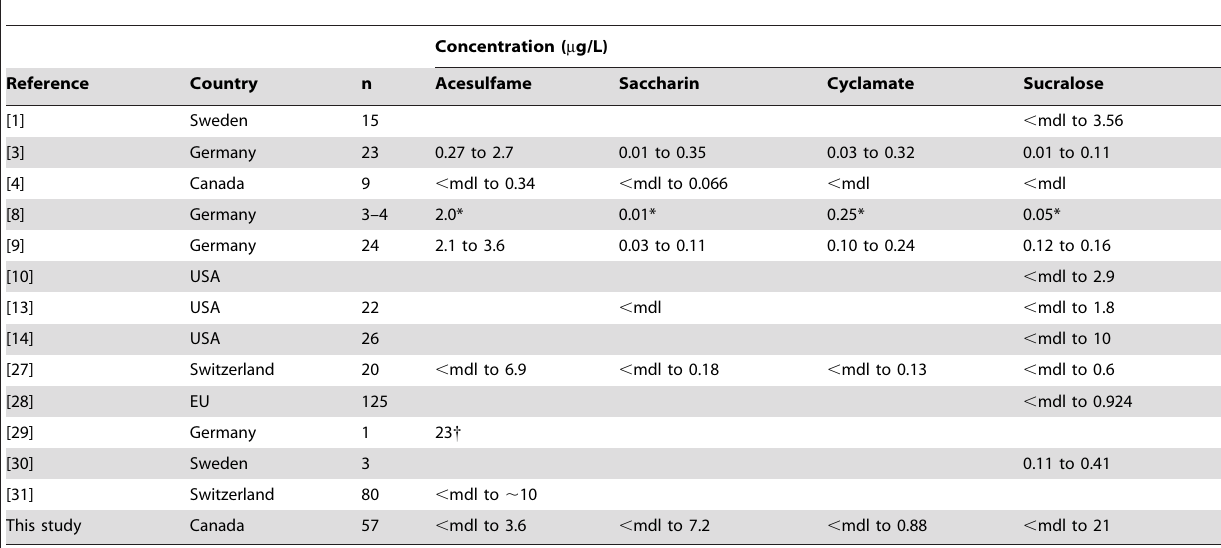
Table 1. Summary of published data on the concentration of artificial sweeteners measured in freshwater surface waters (streams and lakes) and the data from the Grand